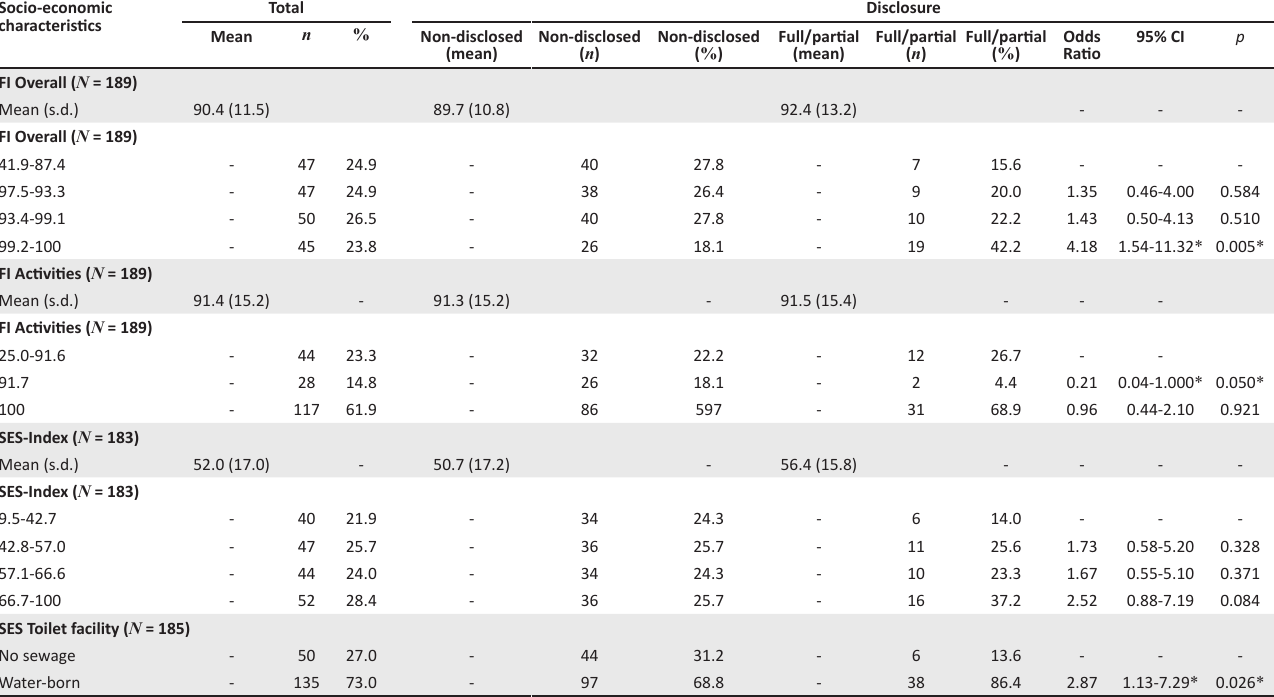
TABLE 4: Associations between disclosure and socio-economic characteristics – Univariate